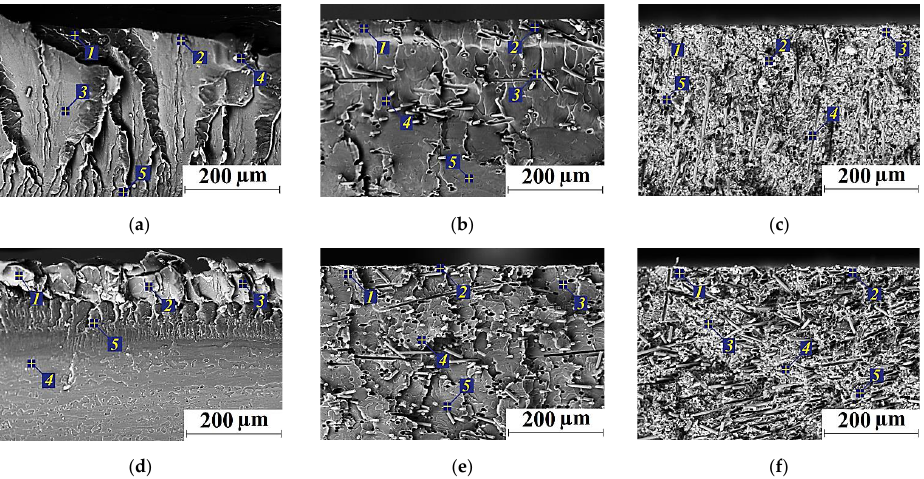
Figure 9. The SEM micrographs of the wear track cross-sections after the tribological tests of neat PI ( а ), PEI ( d ), as well as the PI/10CCF ( b ), PEI/10CCF ( e ) and PI/10CCF/10Gr ( c ), PEI/10CCF/10Gr ( f ) composites.